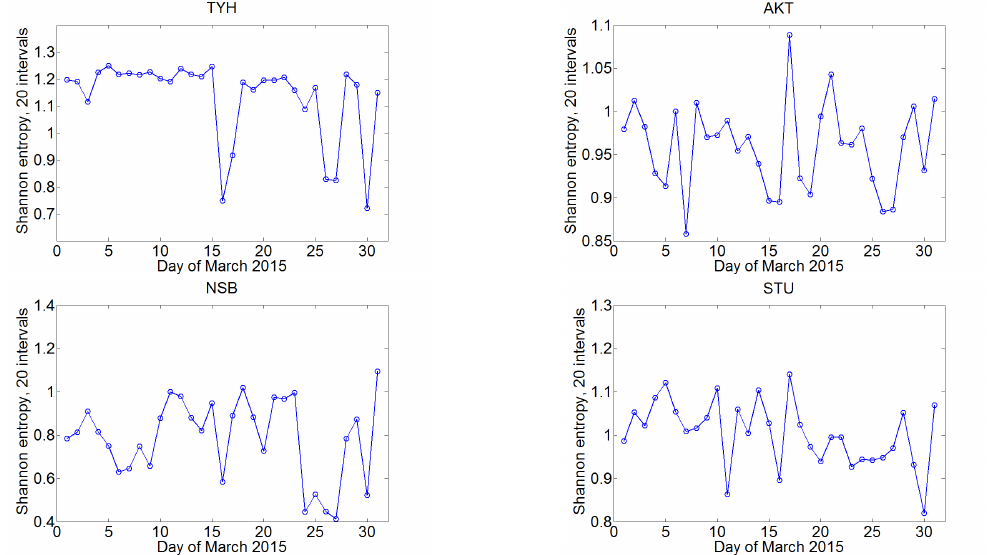
Figure 8. Shannon entropy in March 2015 for the amplitude of the VLF signal from the JJI transmitter to the stations TYH, AKT, NSB,